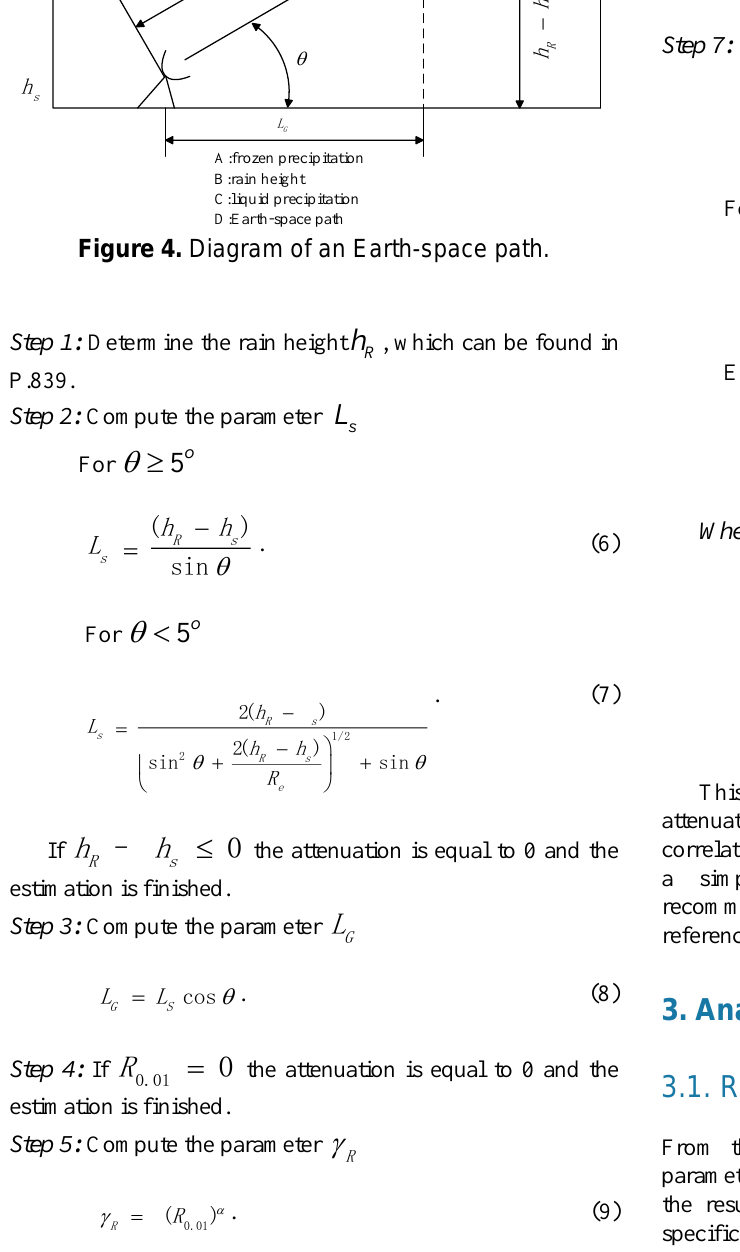
Table 1. The parameters and results of the